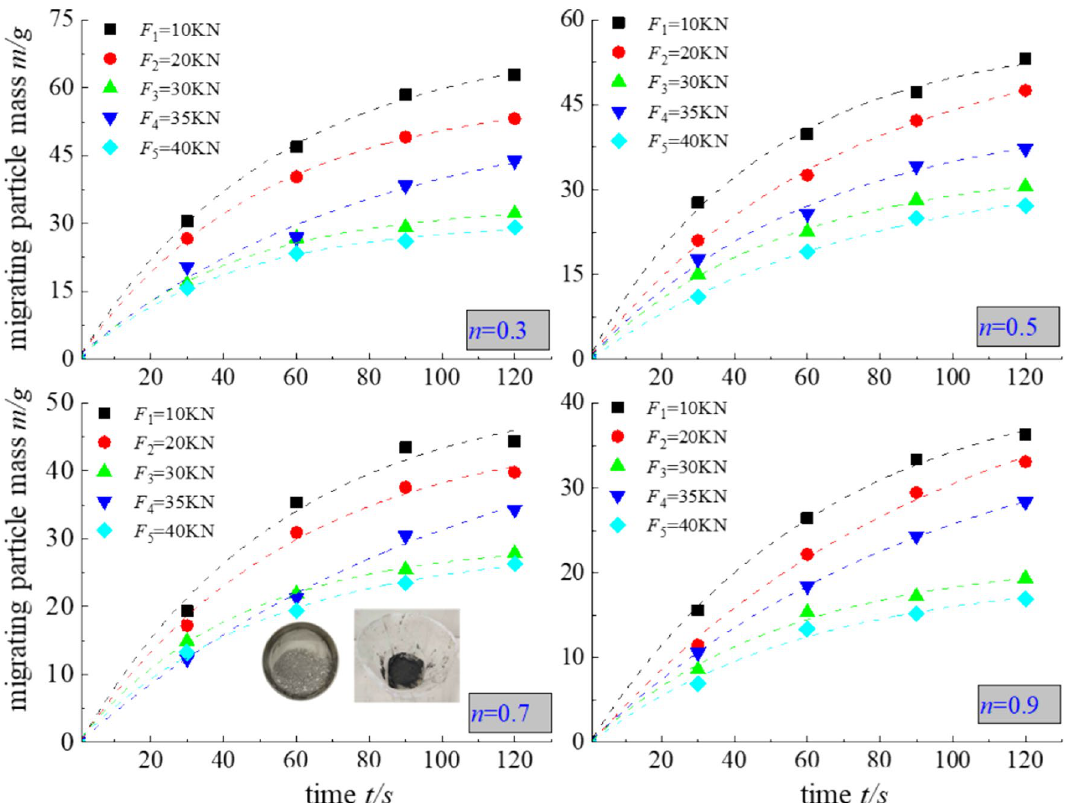
Figure 5. Mass of the migrating particles during the different time periods under the various